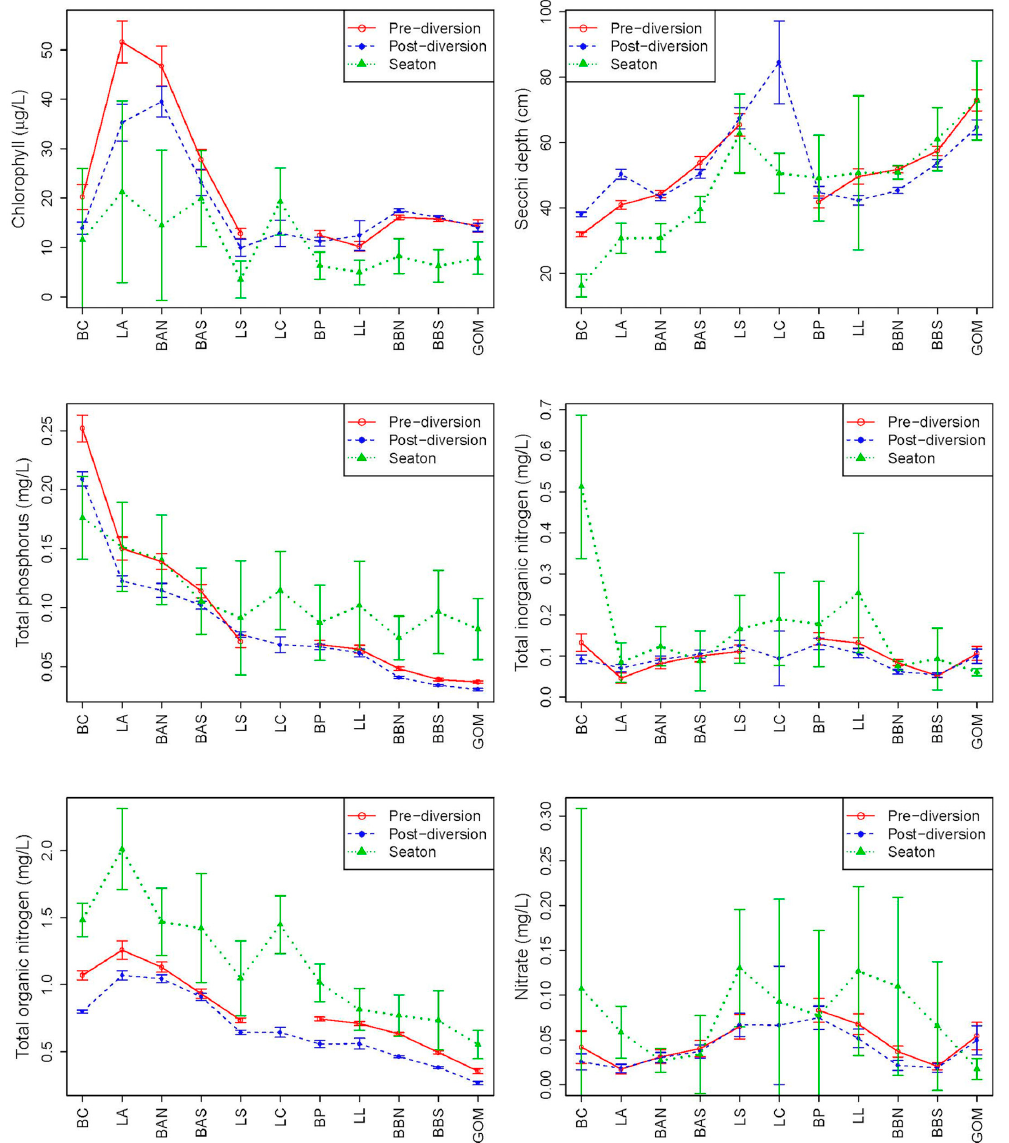
Figure 2. Water quality data from Seaton, Pre- and Post-diversion transects from the upper to lower-basin. The geometric means are provided. The standard error bands are the ones associated with the arithmetic means. Station designations are defined in Figure 1.